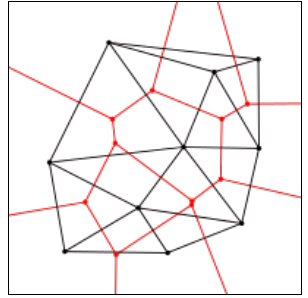
Figure 2. Superposition of a Voronoi diagram (in red) and its Delaunay triangulation (in